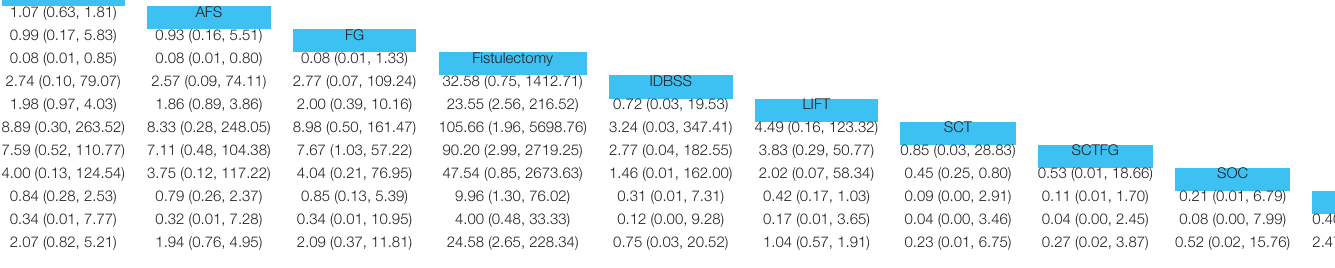
TABLE 3 | Network meta-analysis results of recurrence rate (RR, 95%